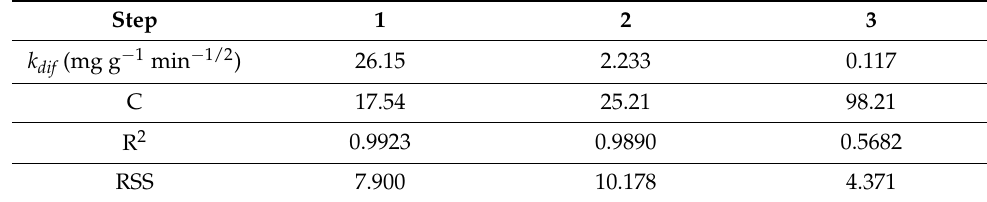
Table 2. Cd ions Intra-particle kinetic transport model and derived